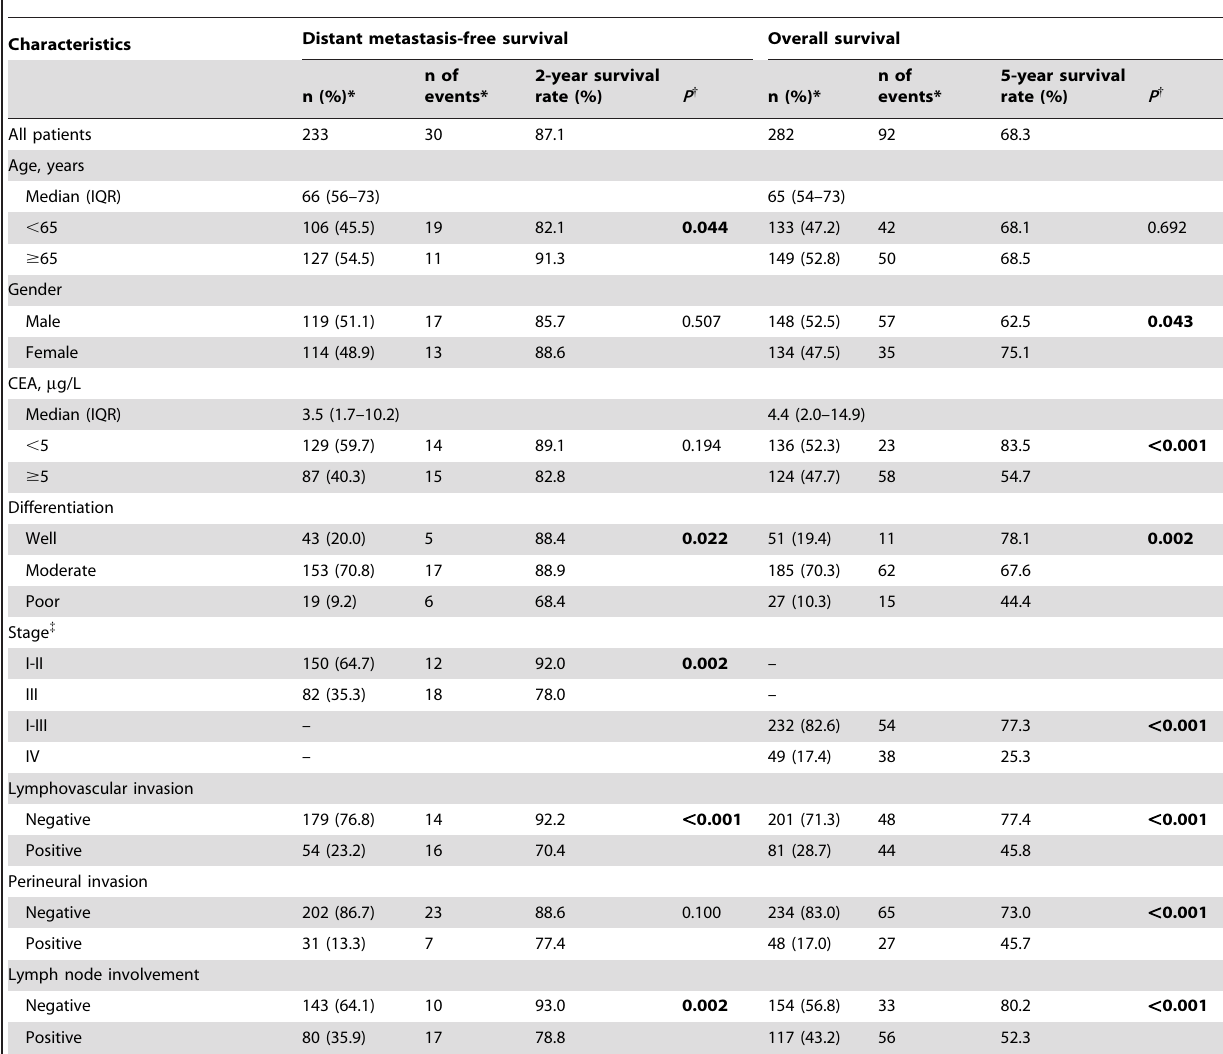
Table 1. Demographic and clinical characteristics of colorectal cancer